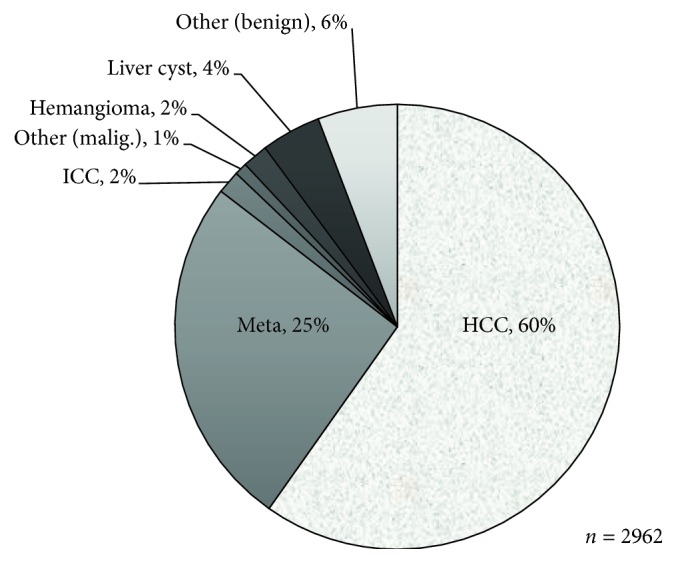
The treated disease.